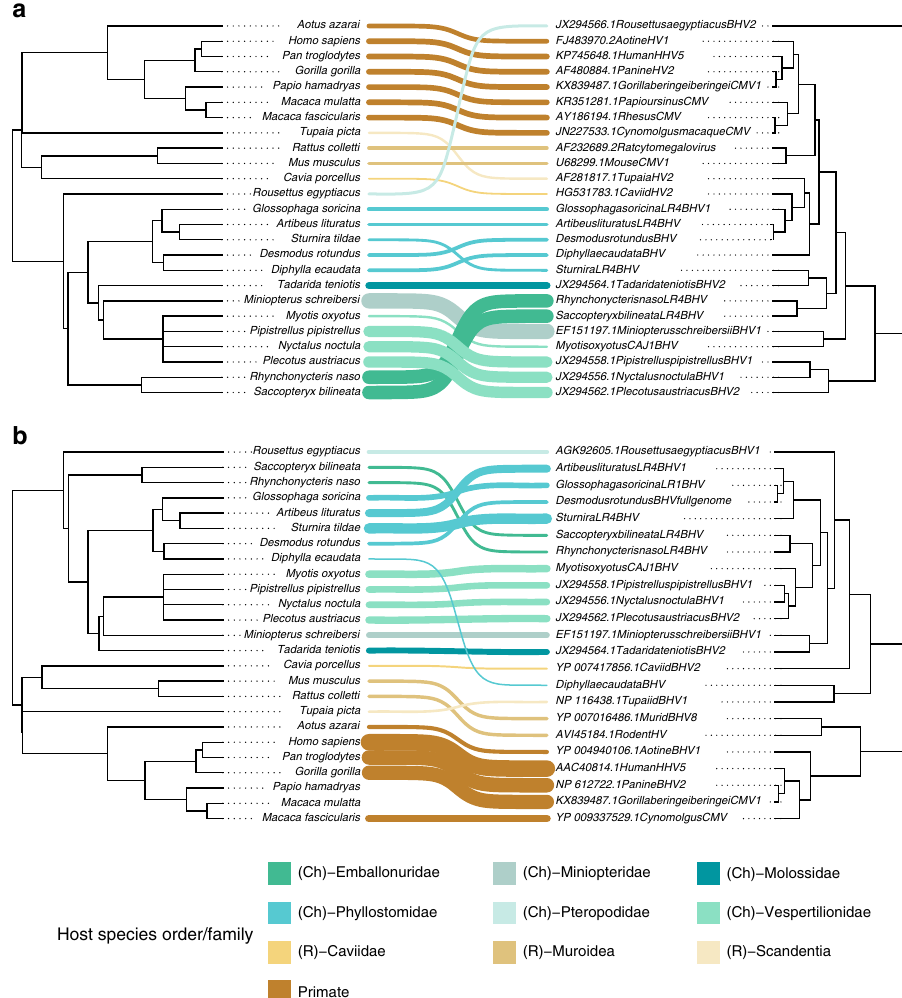
Fig. 4 Co-phylogenetic analysis of hosts and betaherpesviruses reveal co-evolution across mammals. Co-phylogeny of host species (phylogeny extracted from the mammalian super tree 71 ) (left) with BHV, based on viral nucleotide ( a ) and amino acid ( b ) sequences. The lines between trees show links between virus and host phylogenies and are coloured by host family. Link weight is inversely proportional to the PACo squared residual for each species; heavier lines therefore re fl ect the likelihood that a pair represents a co-evolutionary